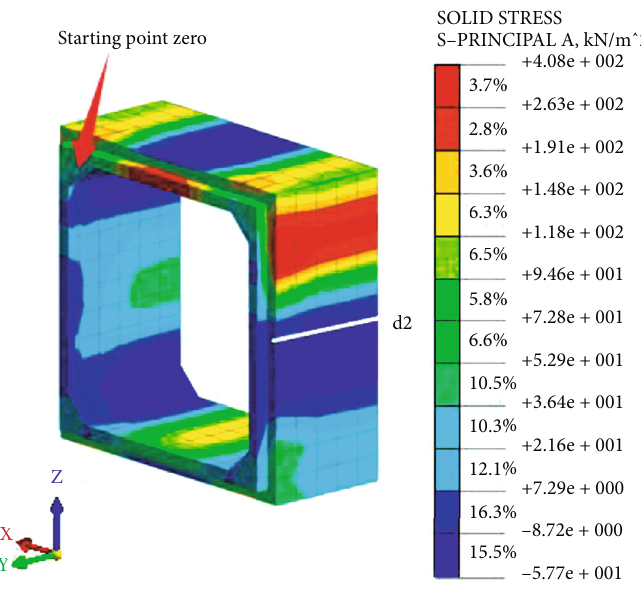
Figure 11: Contour map of maximum principal stress on the M